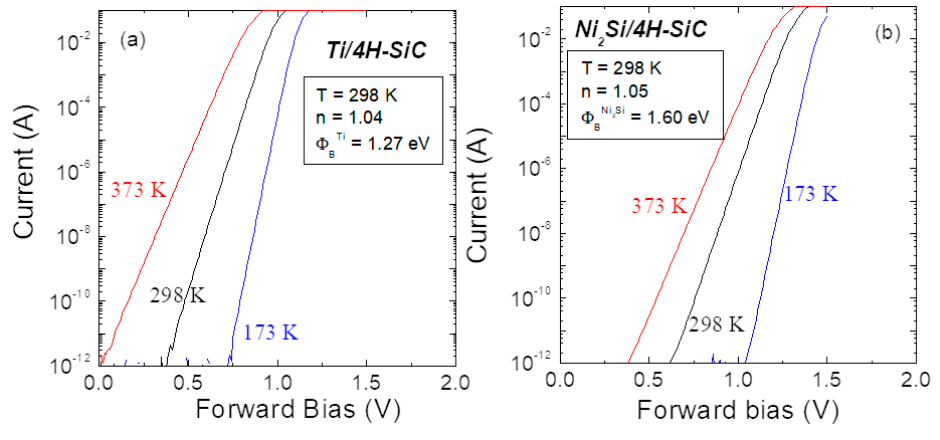
Figure 4. Semilog plot of the temperature-dependent forward-voltage characteristics of 4H-SiC Schottky diodes based on ( a ) Ti and ( b ) Ni 2 Si. Adapted with permission from Ref. [23]. Copyright 2021 AIP Publishing.